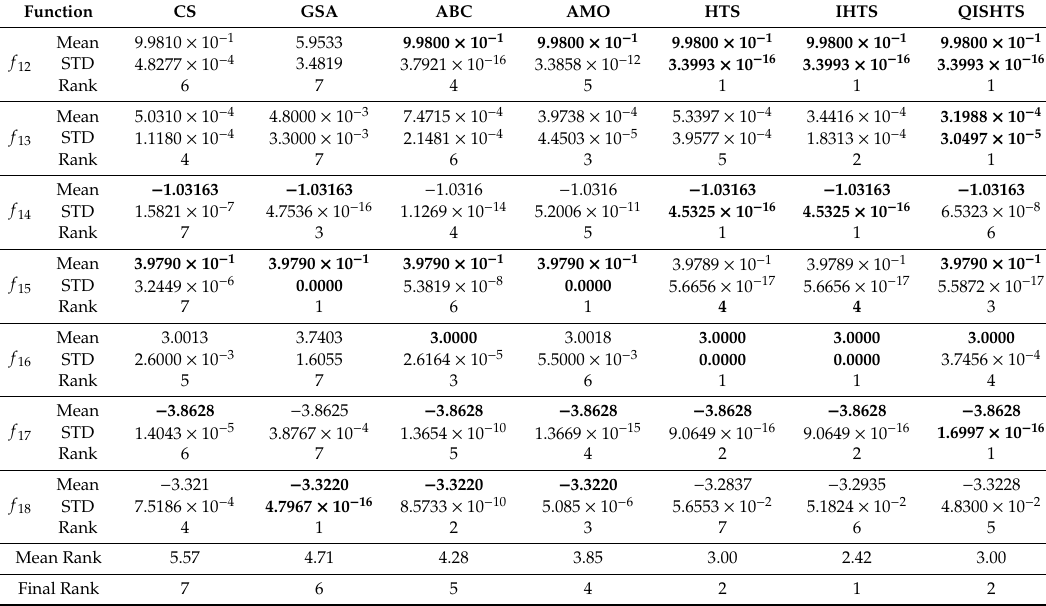
Table 4. Computational results of f 14 – f 23 for the QISHTS algorithm with other MHAs in Investigation 1. (The results of the competitors are adapted from the literature